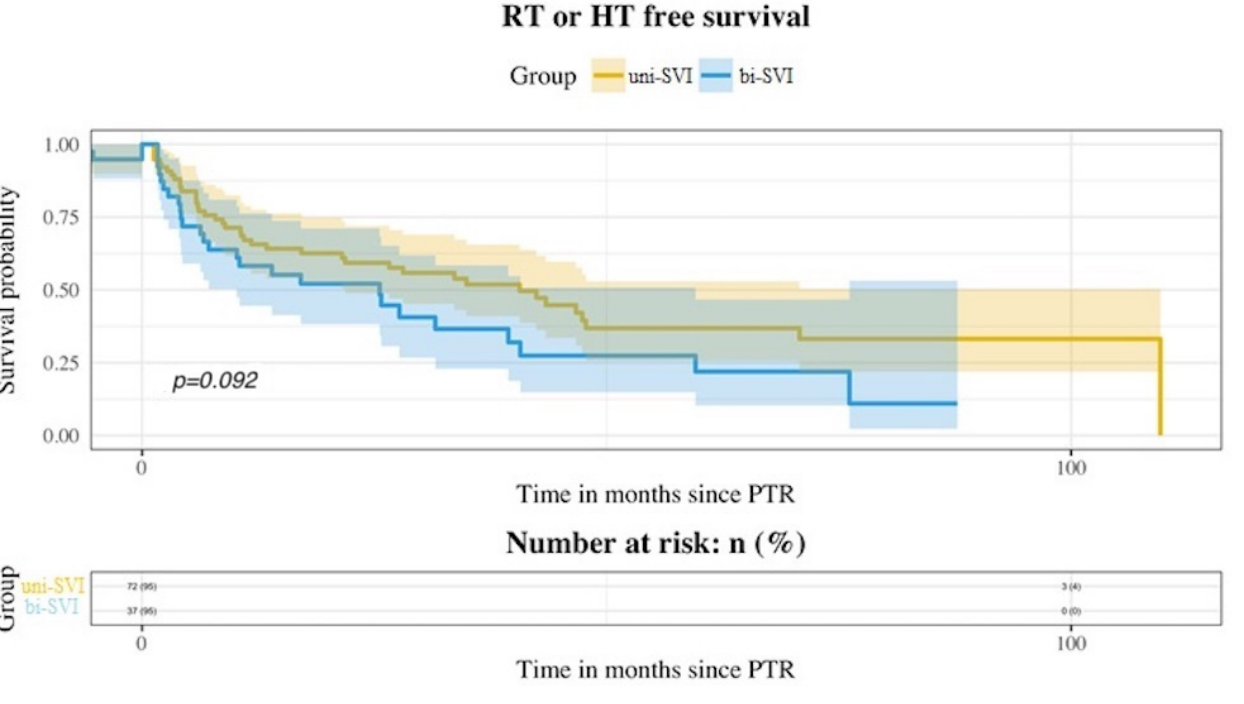
Figure 3. Kaplan–Meier curves showing additional treatment-free survival for both uni-SVI and bi-SVI groups.